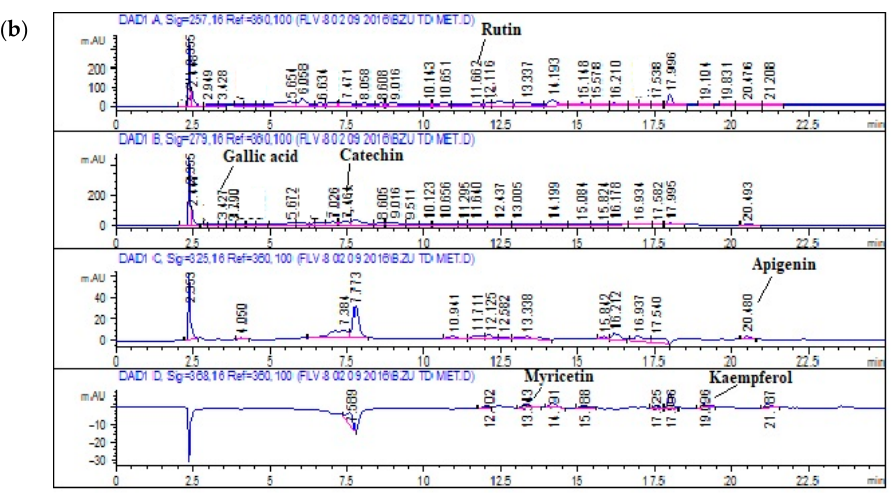
Figure 1. HPLC-DAD chromatograms of ( a ) Standard at 257, 279, 325, and 368 nm; ( b ) Methanolic extract of TdCr extract at 257, 279, 325, and 368 nm.